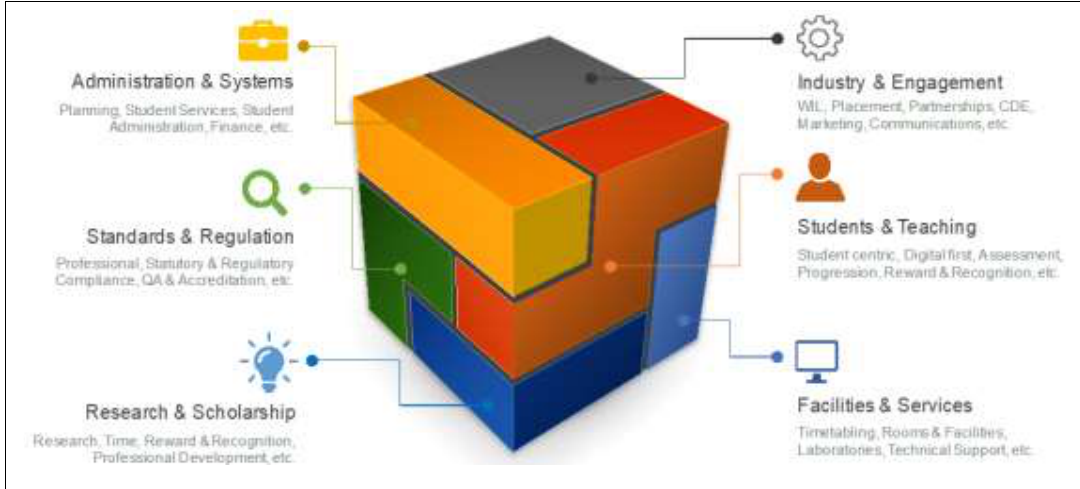
Figure 3. An ecological approach to organisational change at